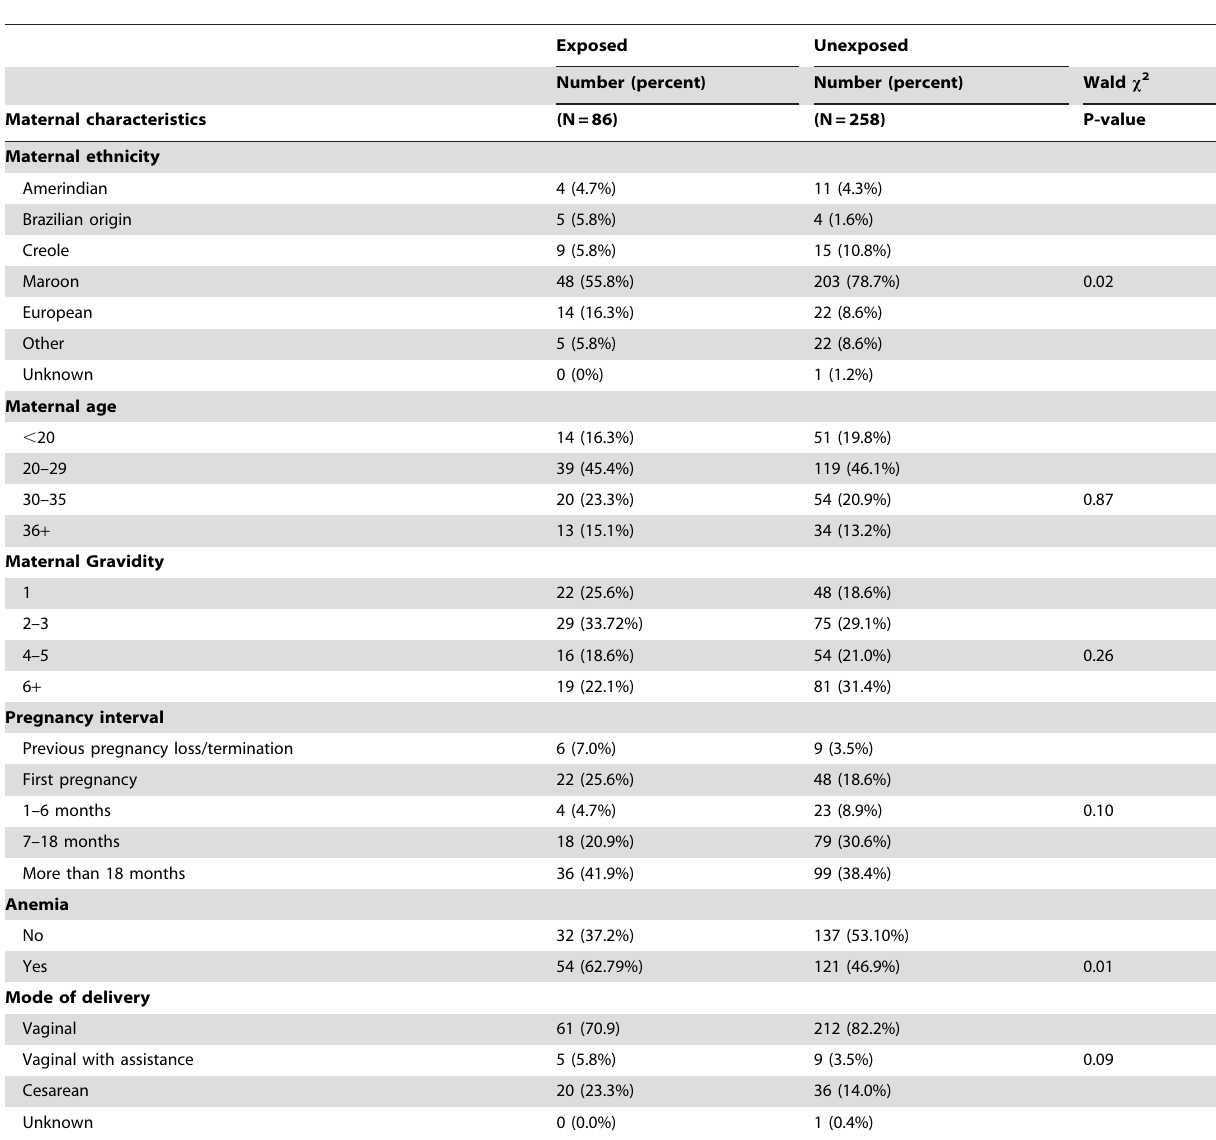
Table 1. Maternal demographic characteristics among the study